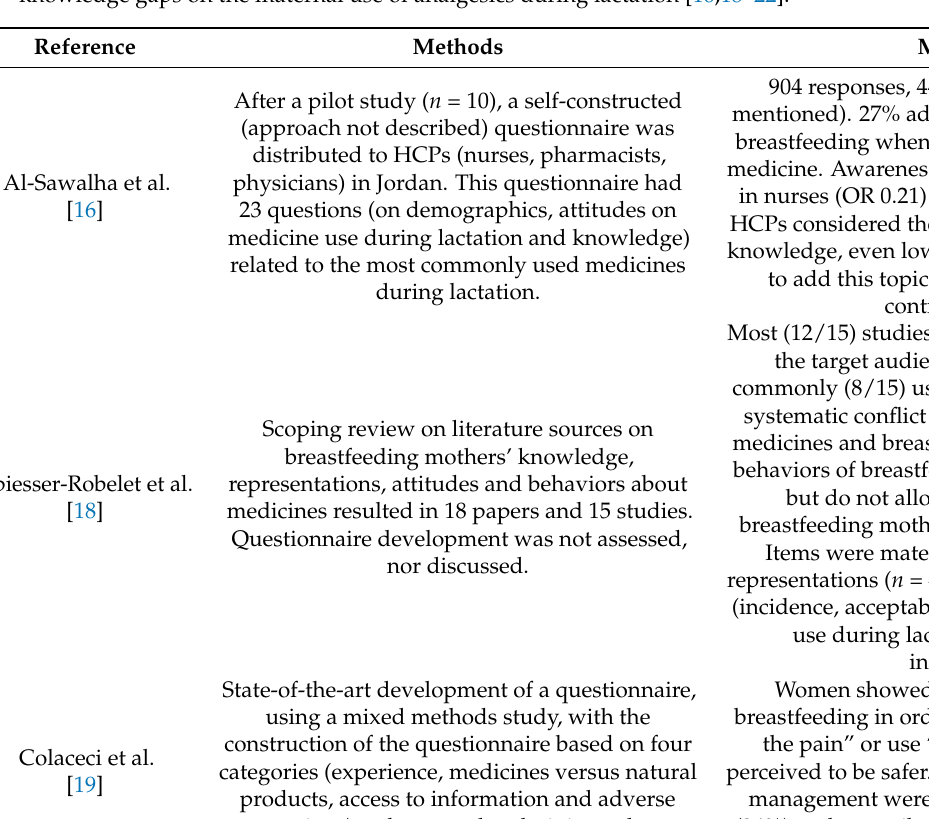
Table 1. Characteristics of the six papers retained based on the literature screening, reflecting different item subgroups of knowledge gaps on the maternal use of analgesics during lactation